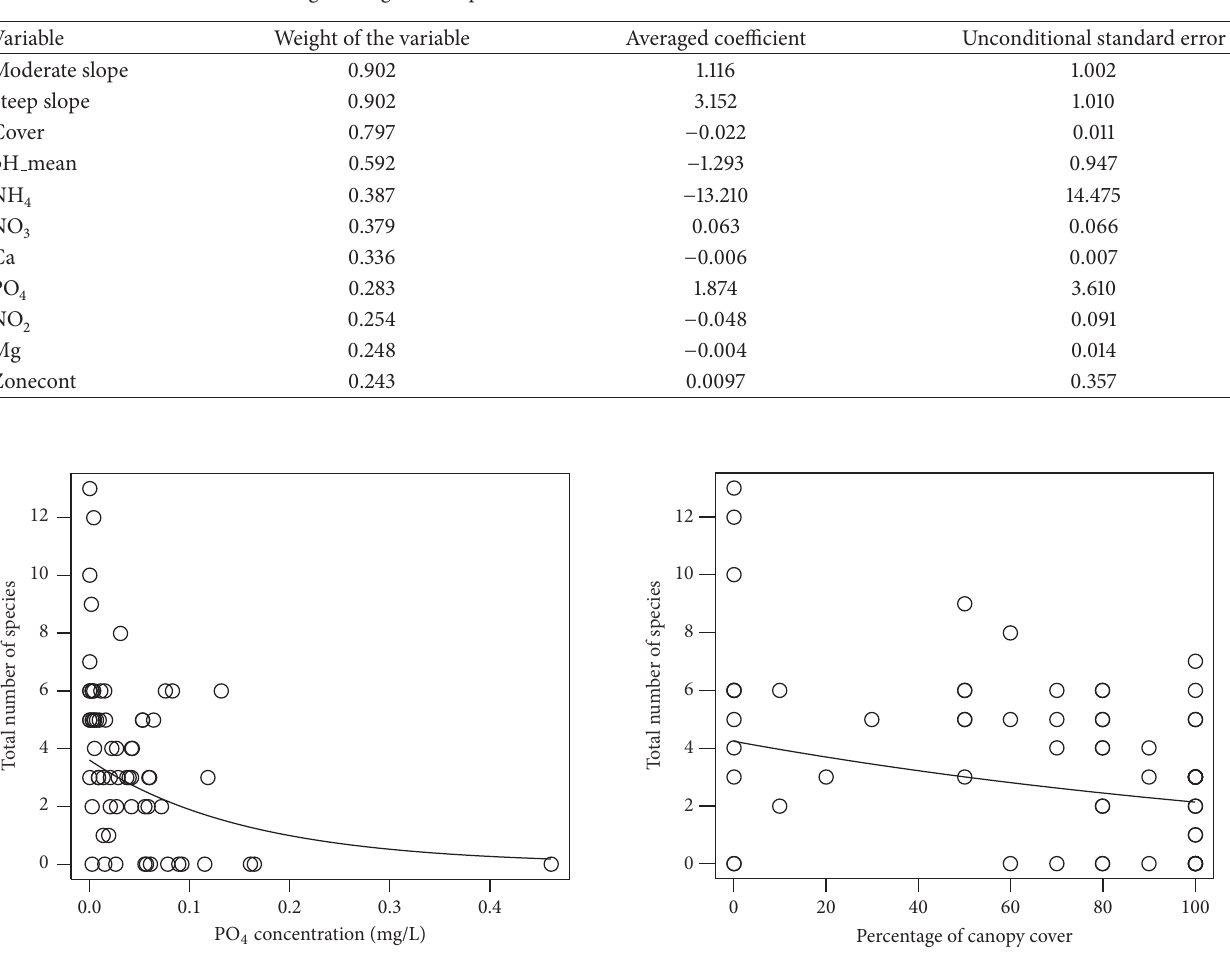
Table 4: Results of the AIC stepwise model selection for probability of presence of Palustriella commutata showing the best significant variables selected based on their weight using the complete dataset.